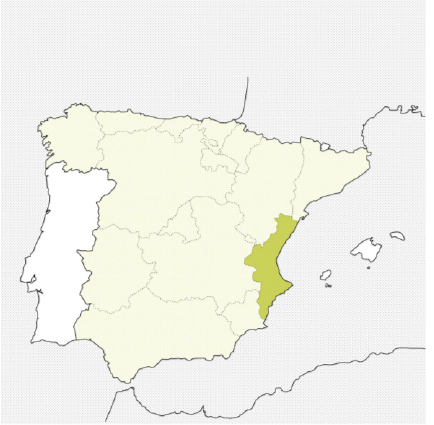
Figure 3. Location of Valencian Community in Spain.